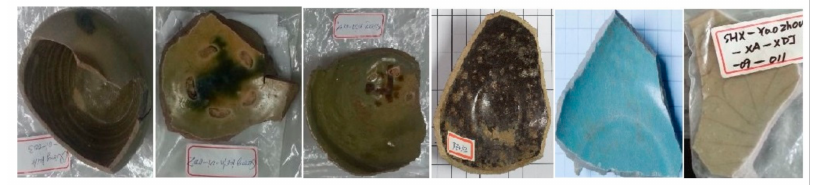
Figure 2. Some examples of the ceramic